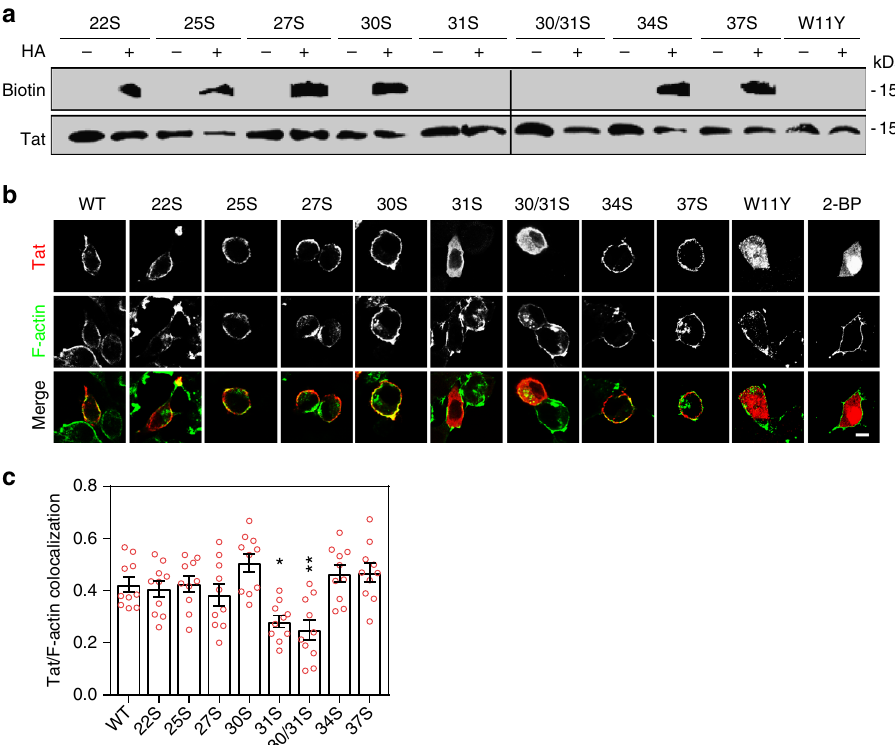
Fig. 2 Tat palmitoylation takes place on Cys31 and requires PI(4,5)P 2 binding. a PC12 cells were transfected with the indicated Tat-FLAG-CXXS or Tat- W11Y mutant before anti-FLAG immunoprecipitation, acyl-biotin exchange (HA, hydroxylamine), western blot and biotin then Tat detection. Images from two blots were assembled. Films with the same exposure time were used and the dashed line marks the separation between them. b Tat-transfected PC12 cells were processed for detection of F-actin using fl uorescent phalloidin and Tat using immuno fl uorescence. When indicated, cells transfected with WT Tat were treated with 100 µ M 2-BP for 5 h before fi xation. Representative median confocal sections are shown. Bar, 5 µ m. c plasma membrane localization of Tat-mutants was evaluated by quantifying Tat/F-actin colocalization using confocal images from n = 10 cells and Mander ’ s coef fi cient calculation (mean ± SEM). The signi fi cance of differences with WT Tat was assessed using one-way ANOVA (* p < 0.05; ** p < 0.01). Similar microscopy data were obtained using primary neurons (Supplementary Fig.